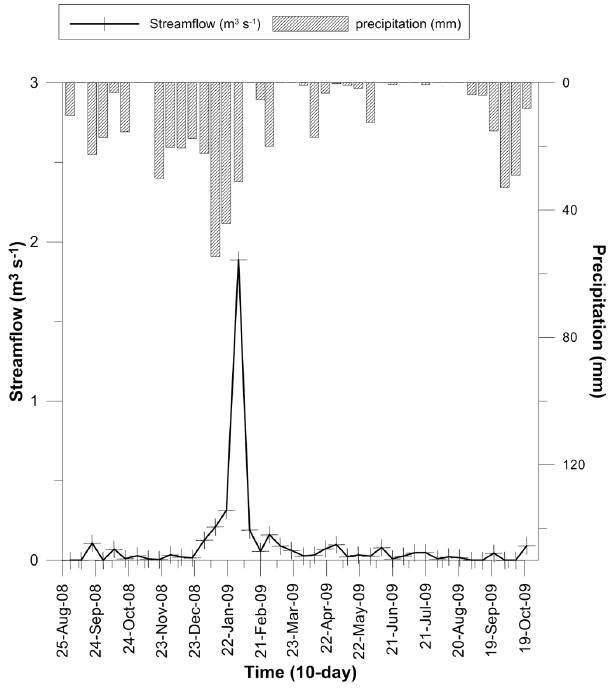
Fig. 2. Decade (10-day) time interval for precipitation and stream- flow of Roxo catchment during the study period (October 2008 to September